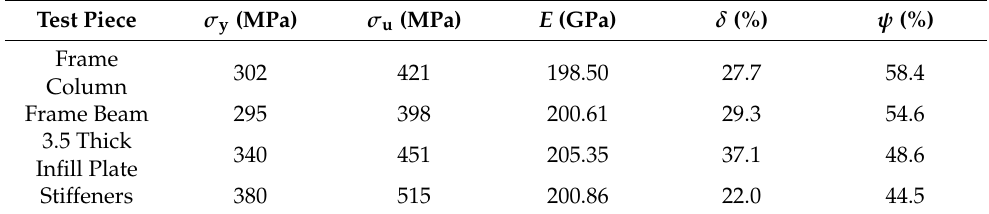
Table 2. Constitutive relation of steel.